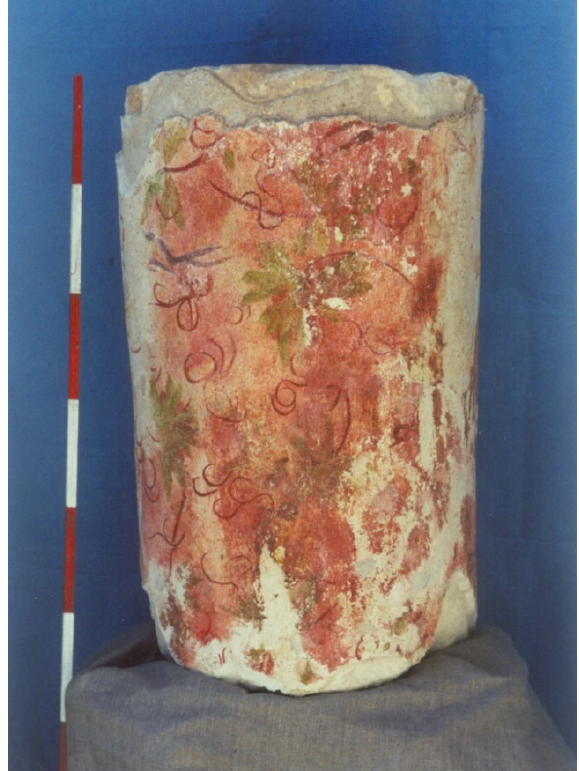
Figure 11. House H21c, element of polychrome column shaft from a commemorative monument dedicated to Emperor Marcus Antoninus Commodus (photo Rafał Czerner).